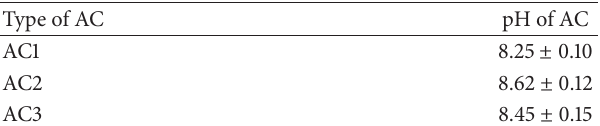
Table 4: PZC for AC1, AC2, and AC3 samples synthesized from IKDP.